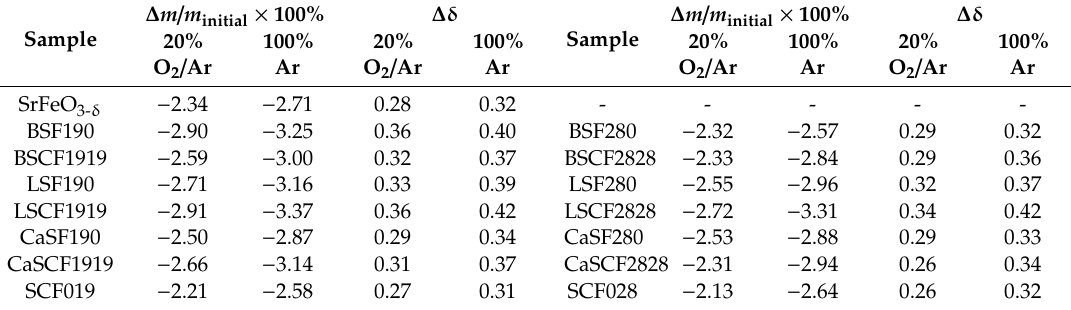
Table3. RelativemasschangeanddeviationfromstoichiometrychangeforA-and / orB-sitesubstitutions in SrFeO 3 − δ for TGA Screening 1 with temperatures between 573 and 1373 K under 20% O 2 / Ar and 100%